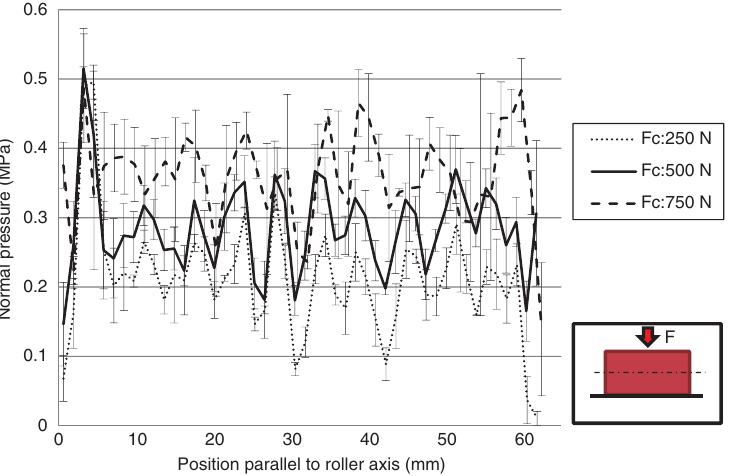
Figure 21 Pressure distribution of the compaction roller on the flat tool parallel to roller